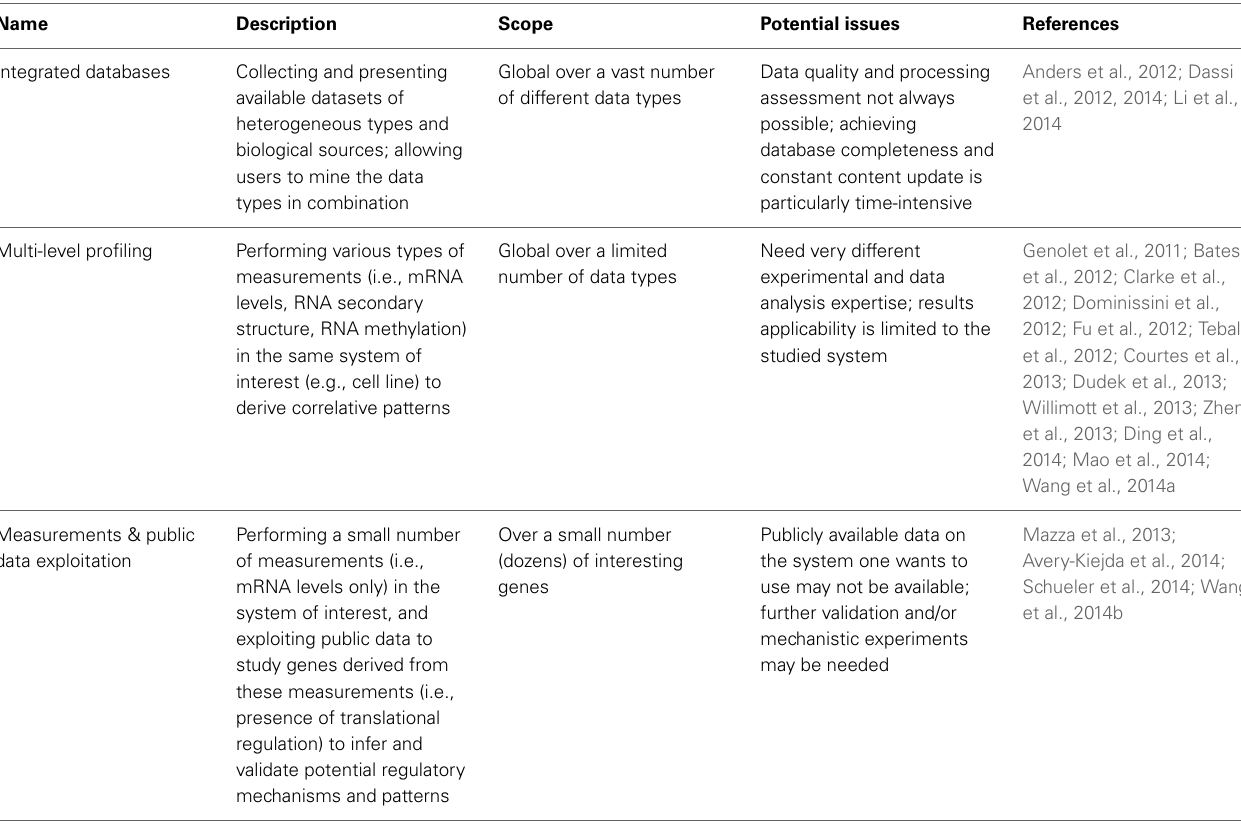
Table 1 | Current approaches for positional information integration on the